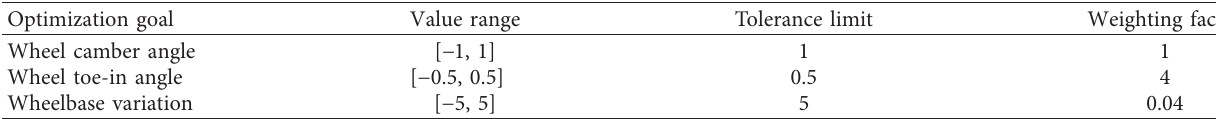
Figure 3: Kinematic model of the integrated E-type multilink suspension wheel-side drive Table 2: Weighting factors for each optimization objective.